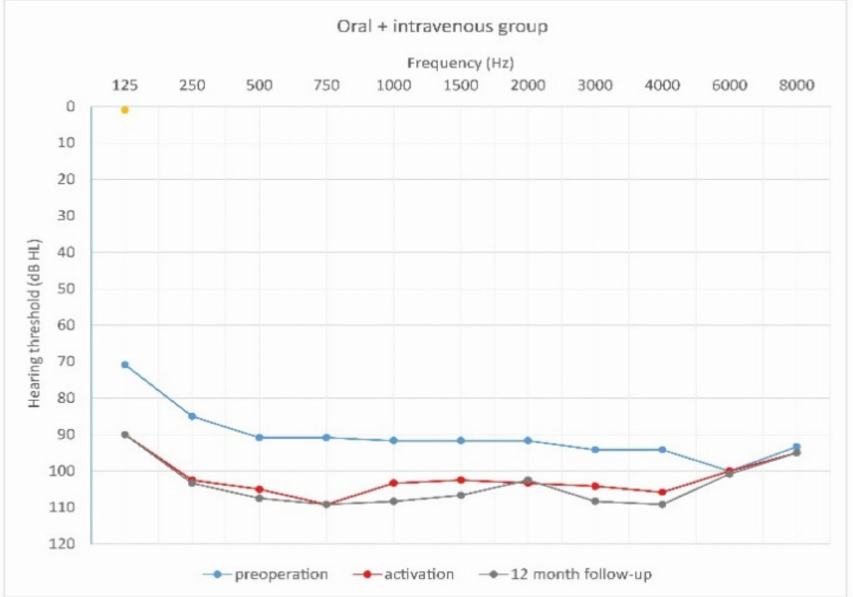
Figure 8. Mean hearing thresholds of patients with prolonged steroid therapy (oral and i.v. group) in the pre-operative period, upon activation, and in the twelve-month follow-up after CI activation.